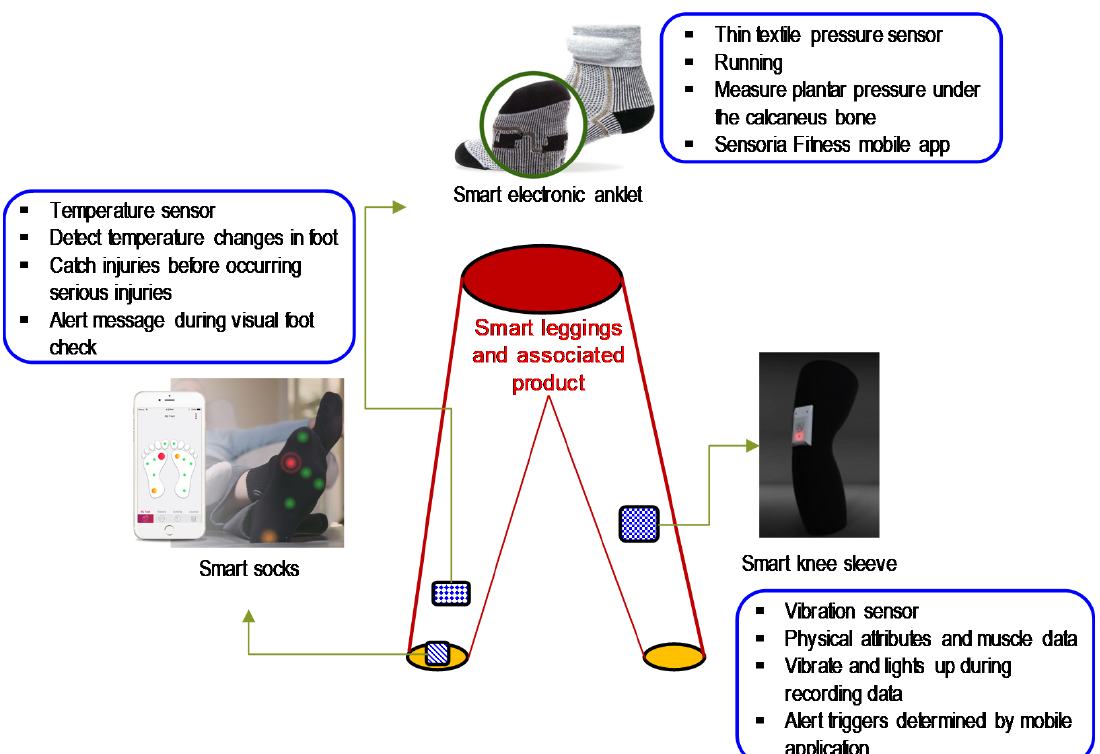
Figure 6. Smart leggings and associated products.